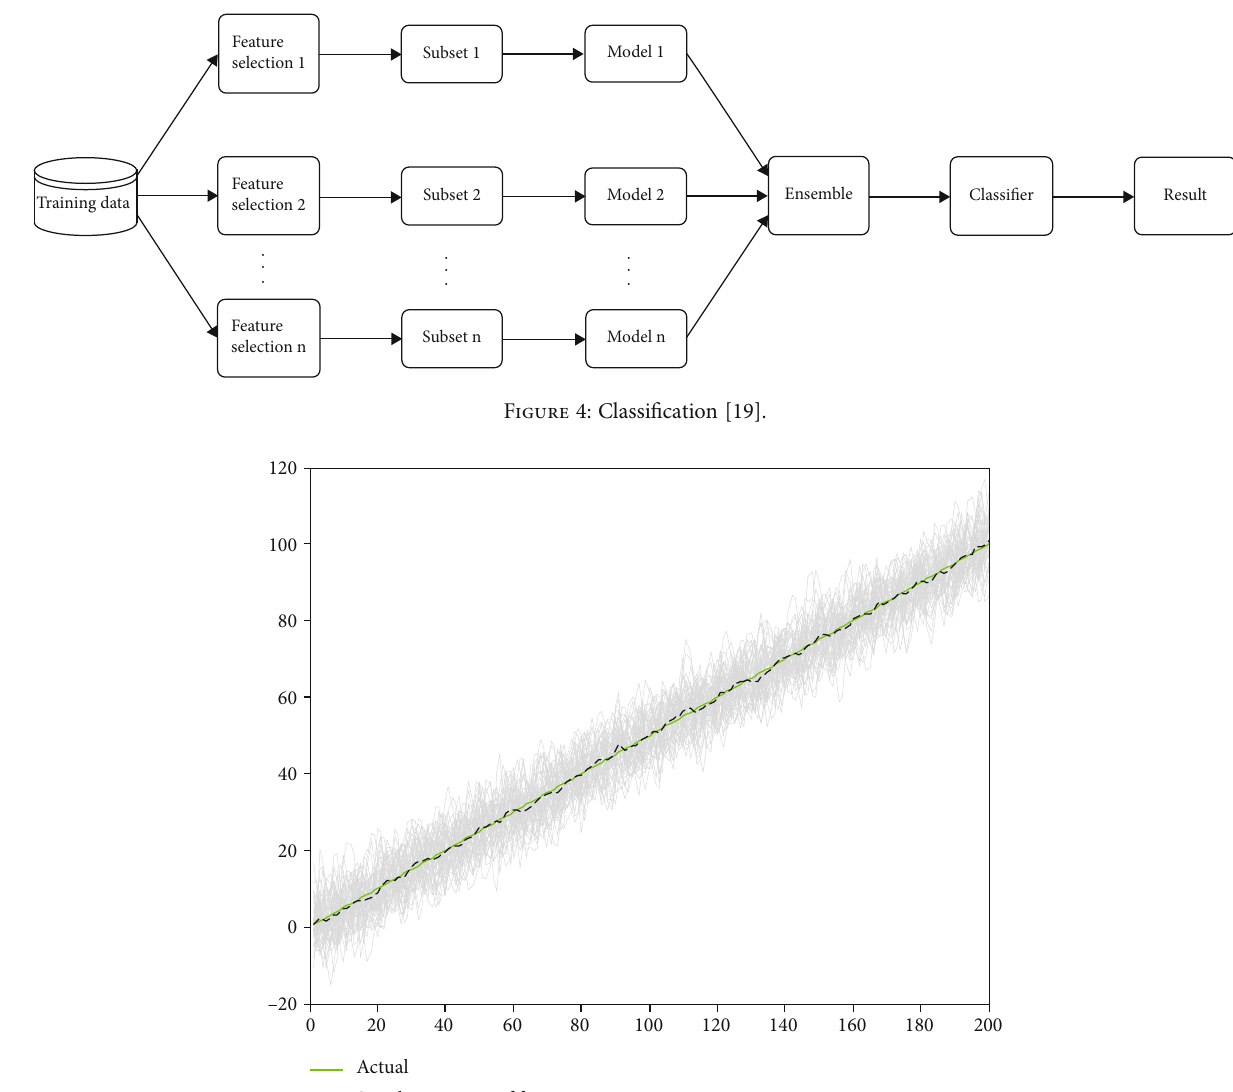
Figure 4: Classi fi cation [19].